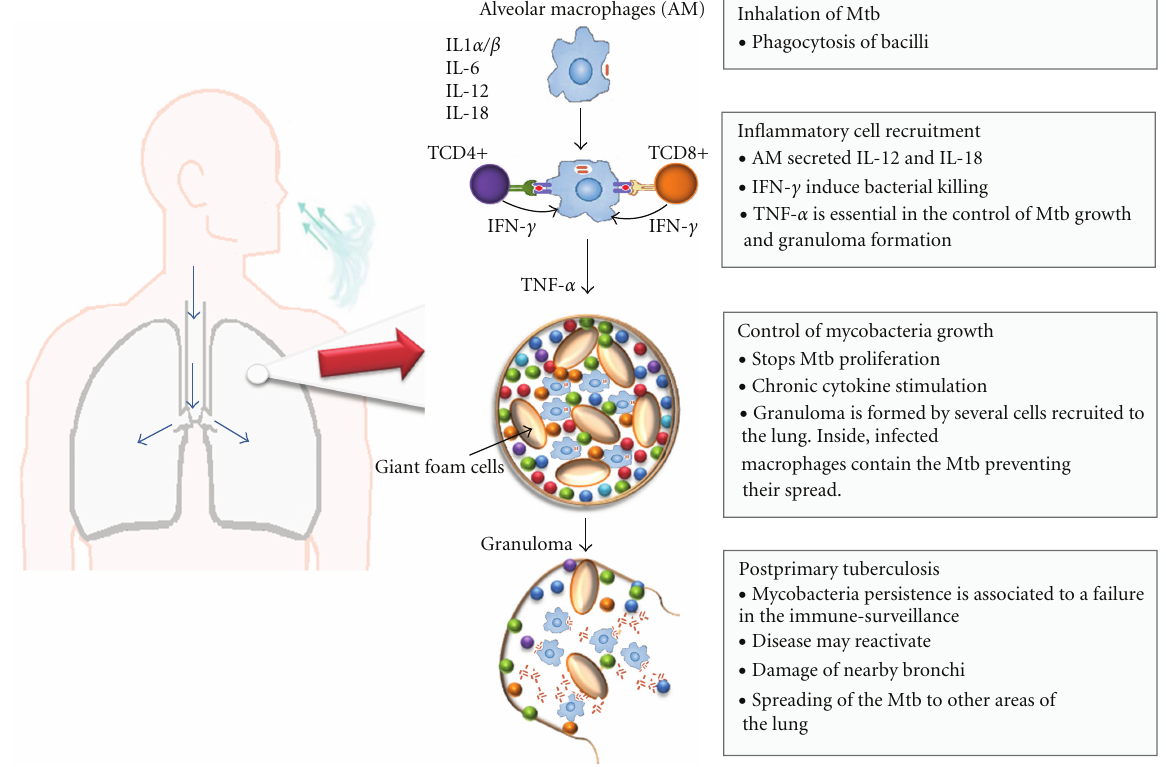
Figure 1: Pathogenesis of tuberculosis. TB pathogenesis can be divided in four well-defined events. Inhalation of the mycobacteria is followed by its interaction with resident macrophages through cellular receptors and its internalization. Macrophage bactericidal mechanisms are then activated, including RNI and ROI generation. The e ffi cient killing of mycobacteria depends on pathogen and host factors. Inflammatory cell recruitment : survived mycobacteria proliferate within macrophages inducing the production of proinflammatory cytokines. The local inflammatory environment induces the recruitment of several cell types including monocytes, neutrophils, and dendritic cells to the site of infection. High levels of TNF- α contribute to control Mtb growth and granuloma formation. Control of mycobacteria proliferation : arrival of immune cells to the site of infection including T cells, which become organized in characteristic structures called granulomas e ffi ciently stop mycobacteria proliferation and contain the mycobacteria within the granuloma walls preventing its spread. Characteristic of this structure is the presence of foam cells resulting from the di ff erentiation of chronically activated macrophages. Mycobacteria containment eventually becomes stable (latent) infection. Postprimary TB : mycobacteria persistence associated with a failure in the immunosurveillance system increases the risk that latent disease becomes reactivated, inducing the damage of nearby bronchi and conditioning the spreading of the Mtb to other areas of the lung and the transmission of the